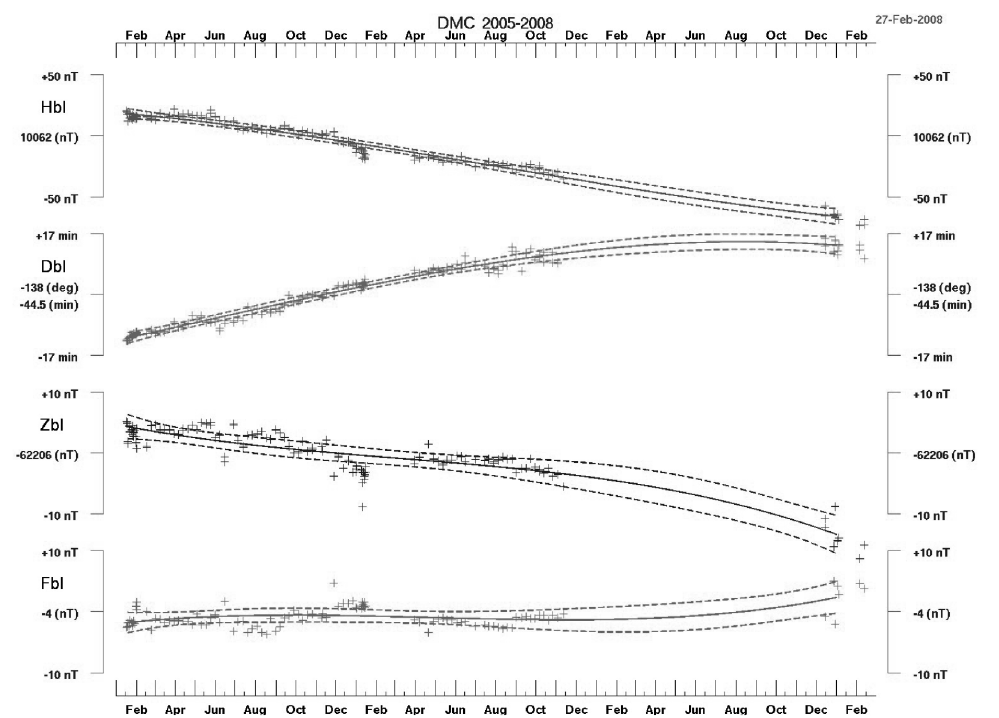
Fig. 4. Same as fig. 2, apart from the fitting model wich is a sequence of orthogonal polynomials up to degree 3. See text for further